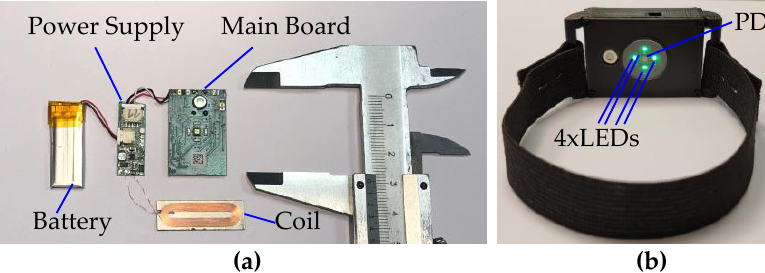
Figure 9. The prototype implementation of a wrist sensor for heart rate measurements with the implemented TDHR algorithm: ( a ) the picture of the internal modules and parts; ( b ) the picture of the final device with strap. The main board has the dimensions of 20 × 30 mm.